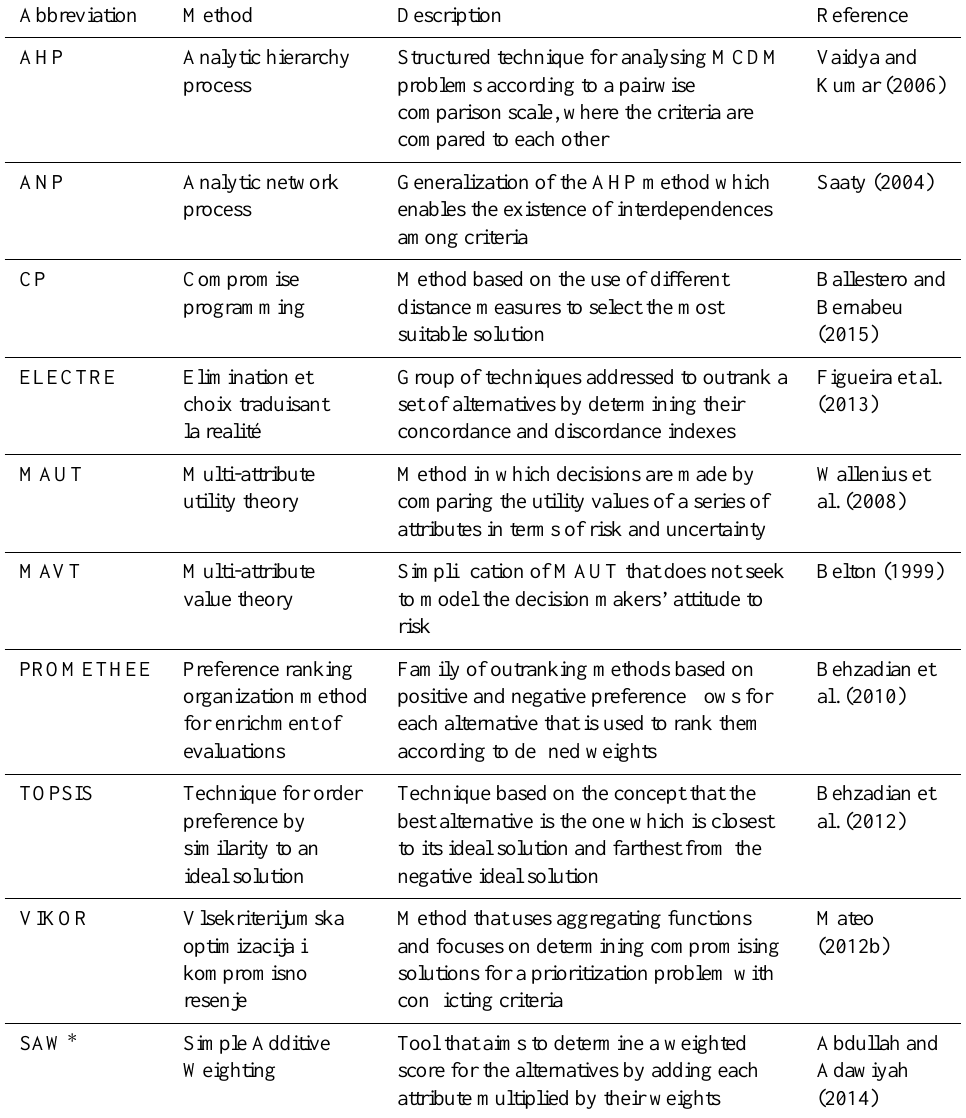
Table 1. Description of different MCDM methods cited in the reviewed